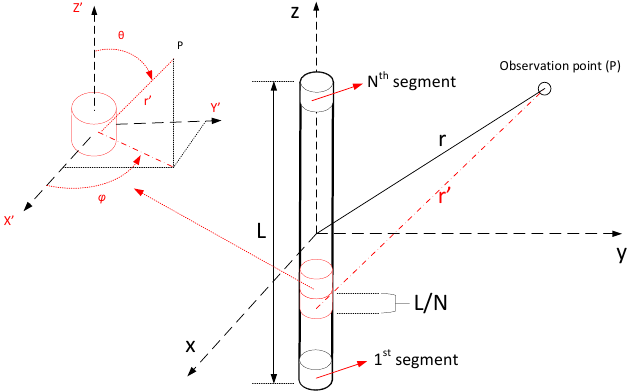
Figure 2. Dipole segmentation for near-field approximation study.